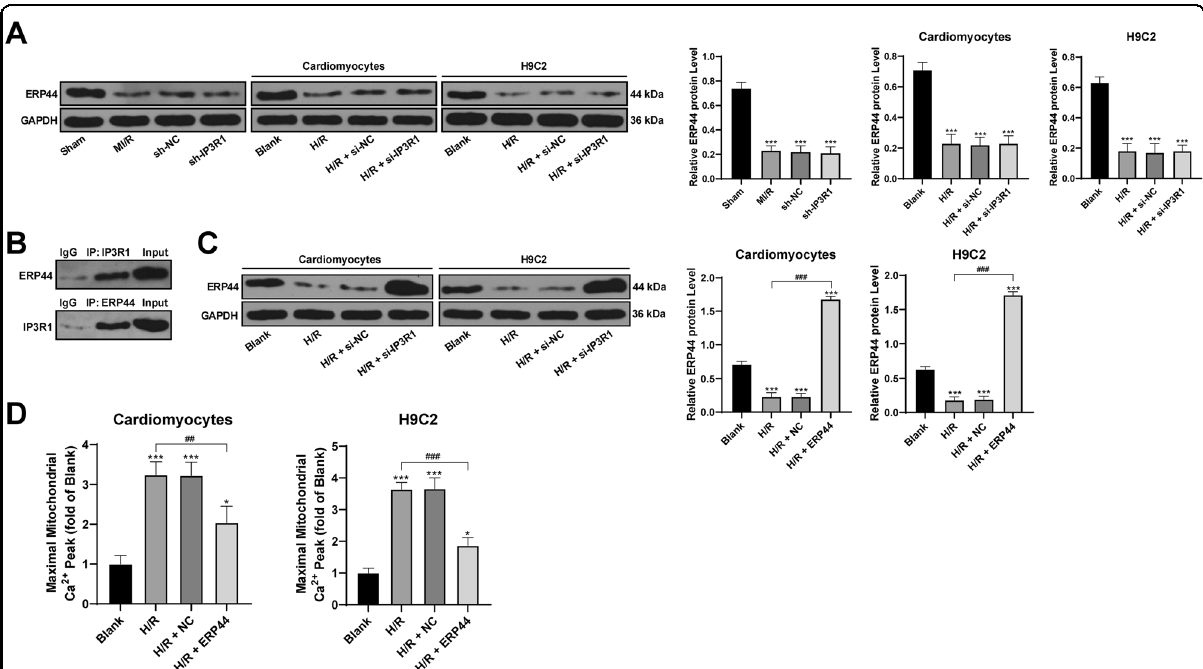
Fig. 4 Binding of ERP44 to IP3R1 inhibits the I/R-induced mitochondrial Ca 2 + overload. A , C Western blot was used to detect the level of ERP44 protein; B immunoprecipitation was used to detect the binding relationship between IP3R1 and ERP44; D Rhod2 AM fl uorescent labeling was used to observe the changes of intracellular Ca 2 + level. Compared to the blank group, * p < 0.05, *** p < 0.001; for pairwise comparison, ## p < 0.01, ### p < 0.001. All experiments were p erformed three times independently. Data were analyzed using one-way ANOVA and Tukey ’ s multiple comparison